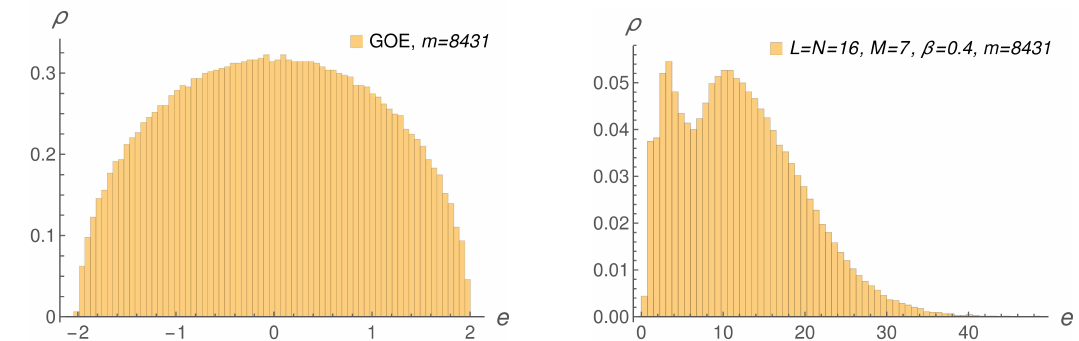
Figure 1: Energy densities for GOE (left) and the β -deformed theory (right). The number of states m is the same in both cases. The distributions are clearly of a different nature, but we find that fluctuations have a similar